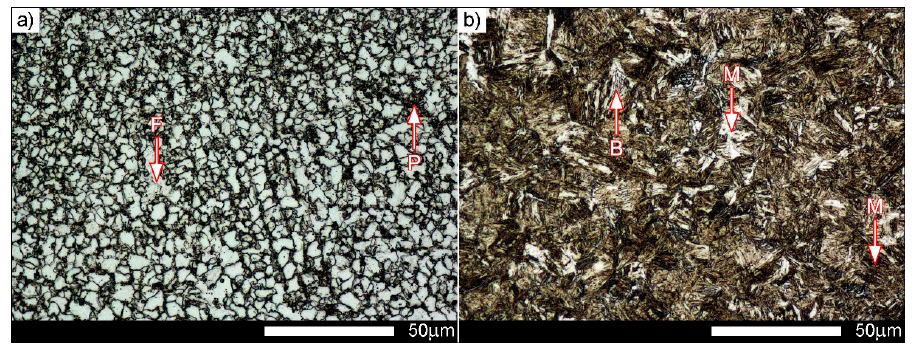
Figure 8. Microstructures of the Hardox 600 joint within the weld metal zone—WM1 in Figure 3: ( a ) after welding; and ( b ) after welding and heat treatment. B—bainite, F—ferrite, M—martensite, P—pearlite. Light microscopy, etched with 2% HNO 3 .